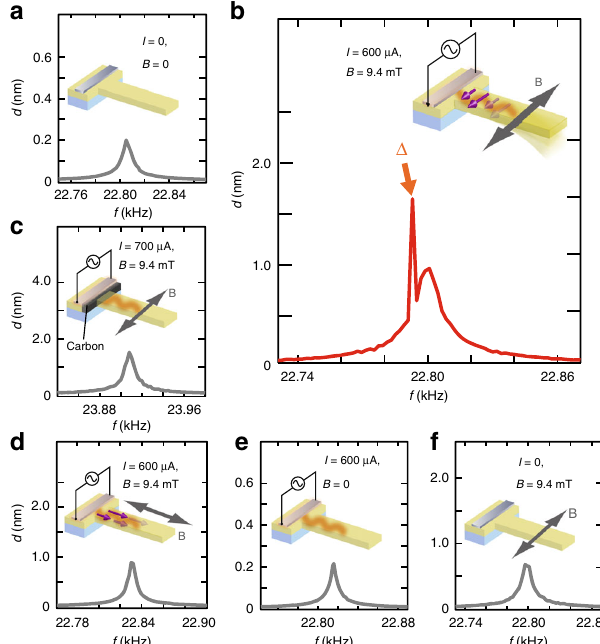
Fig. 3 Amplitude of cantilever fl uctuation d as a function of fl uctuation frequency f . a Background thermal fl uctuation. The spectrum was obtained without any external excitation. A broad peak around 22.8 kHz is the fundamental thermal vibration of the cantilever induced just by heat. b Fluctuation spectrum obtained with an a.c. current and an a.c. fi eld perpendicular to the cantilever. The frequencies of the current f H /2 and the fi eld F are 9.8960 kHz and 3.0010 kHz, respectively. A sharp peak is labeled as Δ . c Fluctuation spectrum obtained for the control sample with an a.c. current and an a.c. fi eld perpendicular to the cantilever. The frequencies of the current f H /2 and the fi eld F are 10.4272 and 3.0500 kHz, respectively. d Fluctuation spectrum obtained with an a.c. fi eld parallel to the cantilever and an a.c. current. The frequency of the current f H /2 and the fi eld F are 9.9038 and 3.0010 kHz, respectively. e Fluctuation spectrum obtained with an a.c. fi eld perpendicular to the cantilever without current. The frequency of the fi eld is 3.0010 kHz. f Fluctuation spectrum obtained with an a.c. current without fi elds. The frequency of the